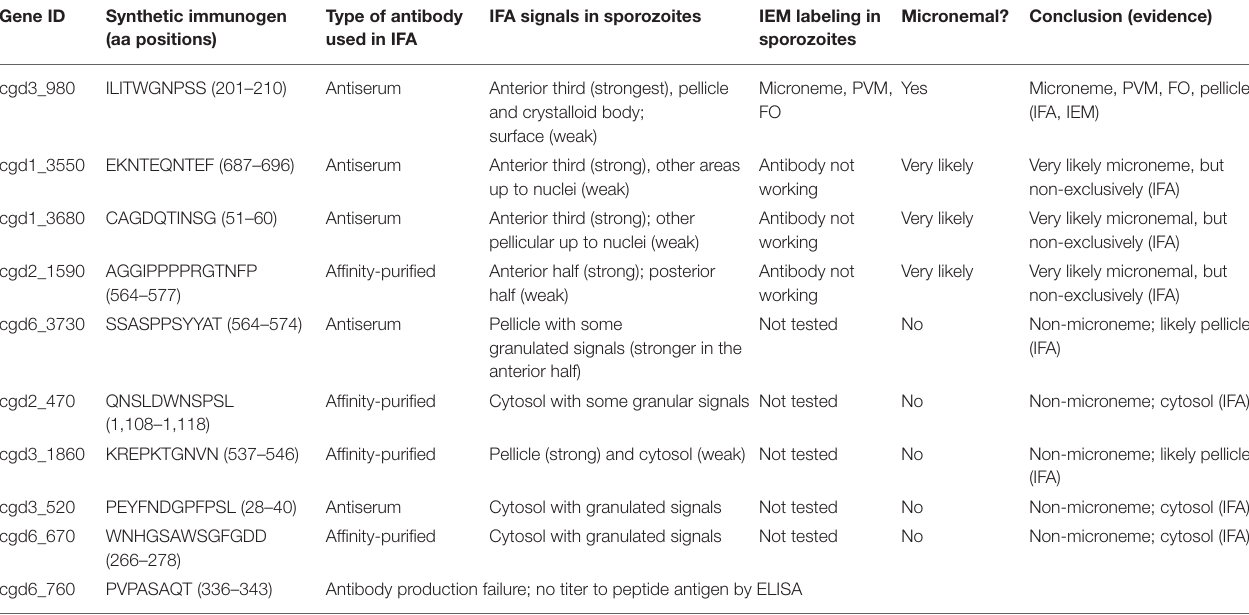
TABLE 1 | List of candidate microneme proteins and summary of observations in this study a . Gene